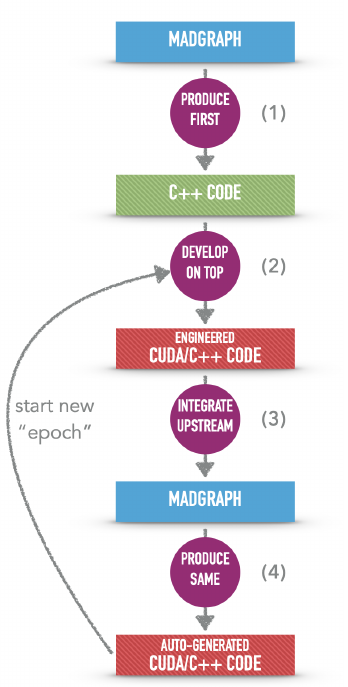
Figure 2. The overall software en- gineering process is